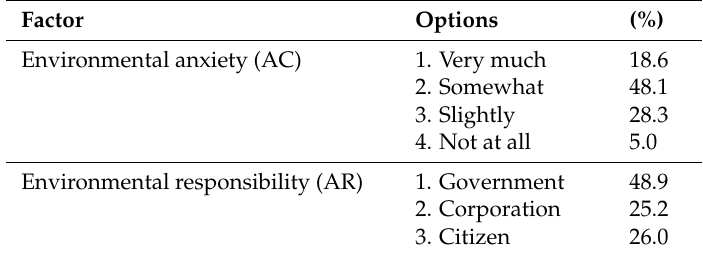
Table A1. Responses to environmental anxiety and environmental responsibility question items.